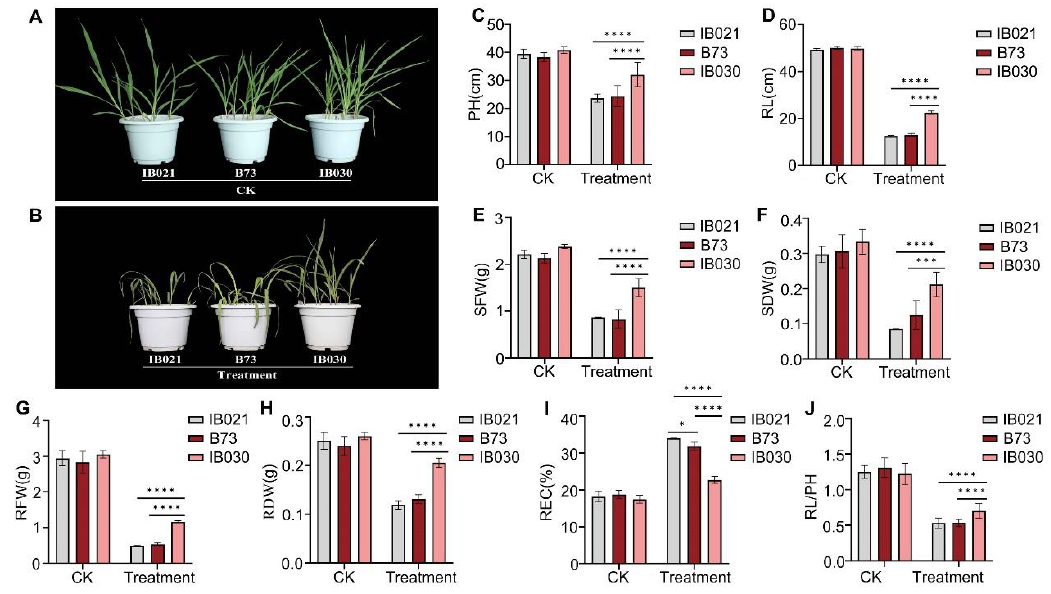
Figure 1. Phenotypes and statistical comparison of cold-resistant MIL-IB030, cold-sensitive MIL- IB021, and recurrent parent B73 under normal and low-temperature stress conditions. Note: ( A ) and